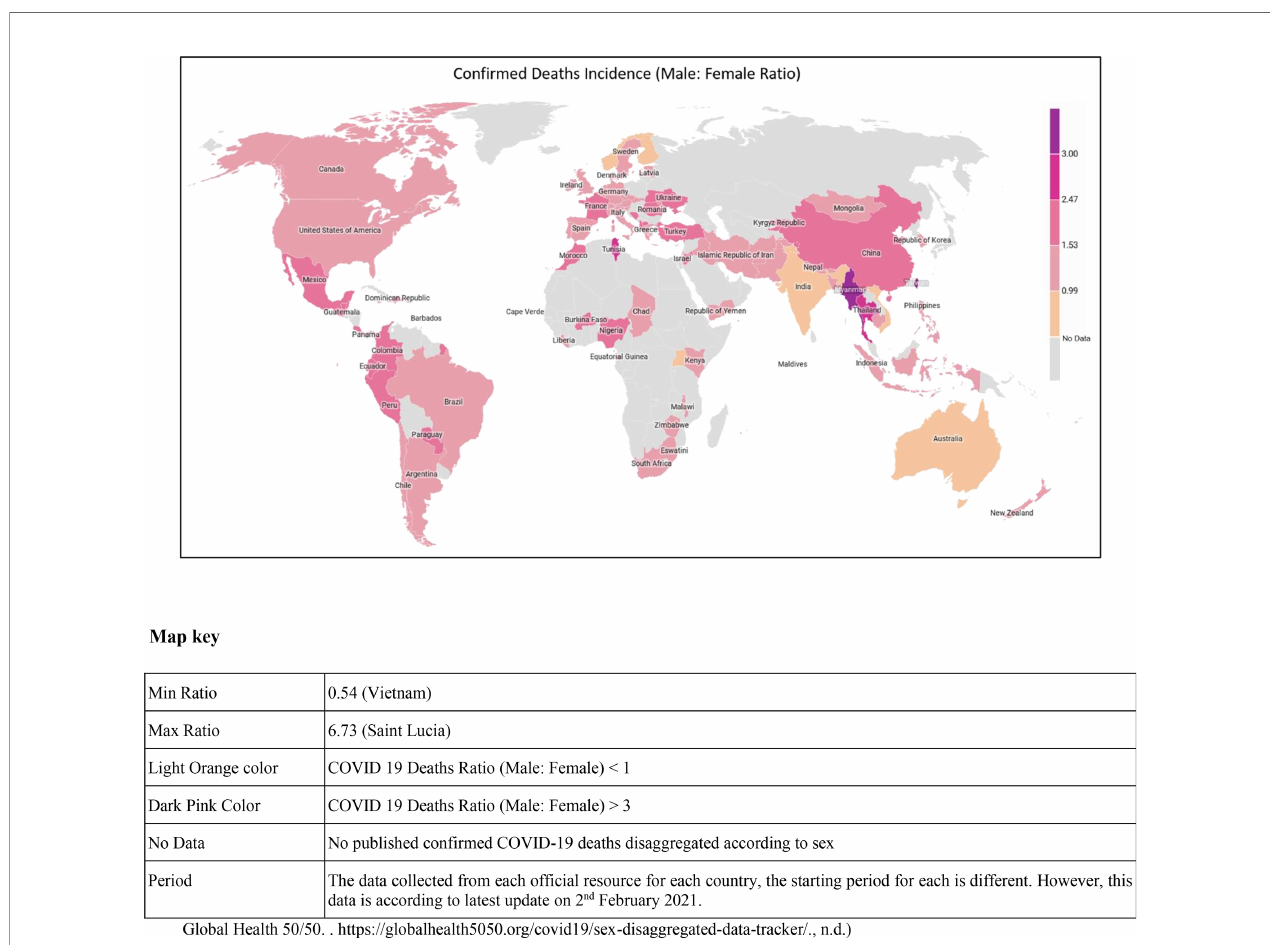
FIGURE 1 | Global map showing the con fi rmed COVID-19 death incidence (male and female ratio) in various